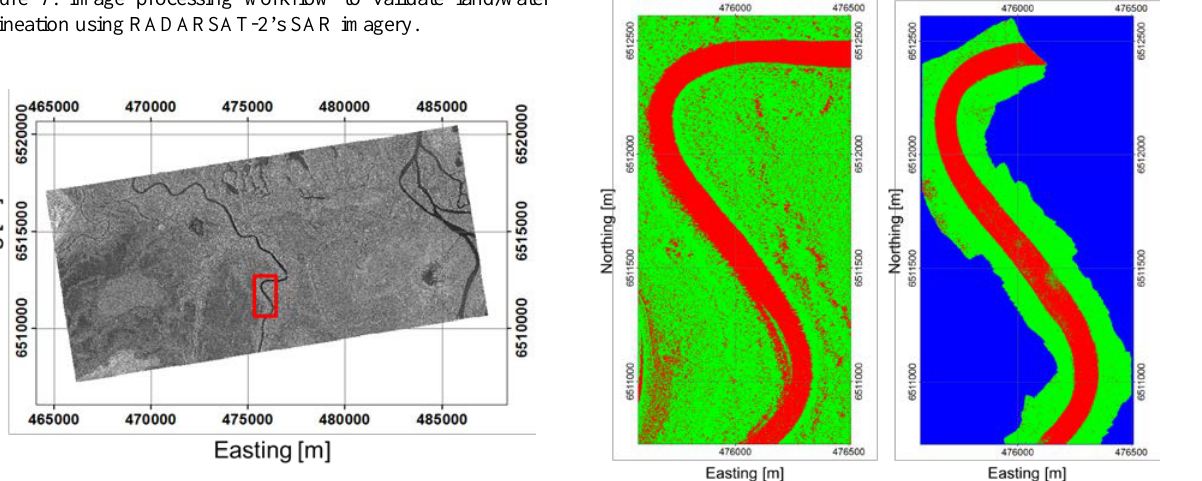
Figure 8. Geocoded RADARSAT-2 intensity image from June 27, 2015 using mode SLA16 with an incidence angle of 42 degrees acquired on an ascending pass looking right. The red rectangle outlines the area of interest, a segment of the Quatre Forches River. The image is projected in NAD83 UTM Zone 12N.